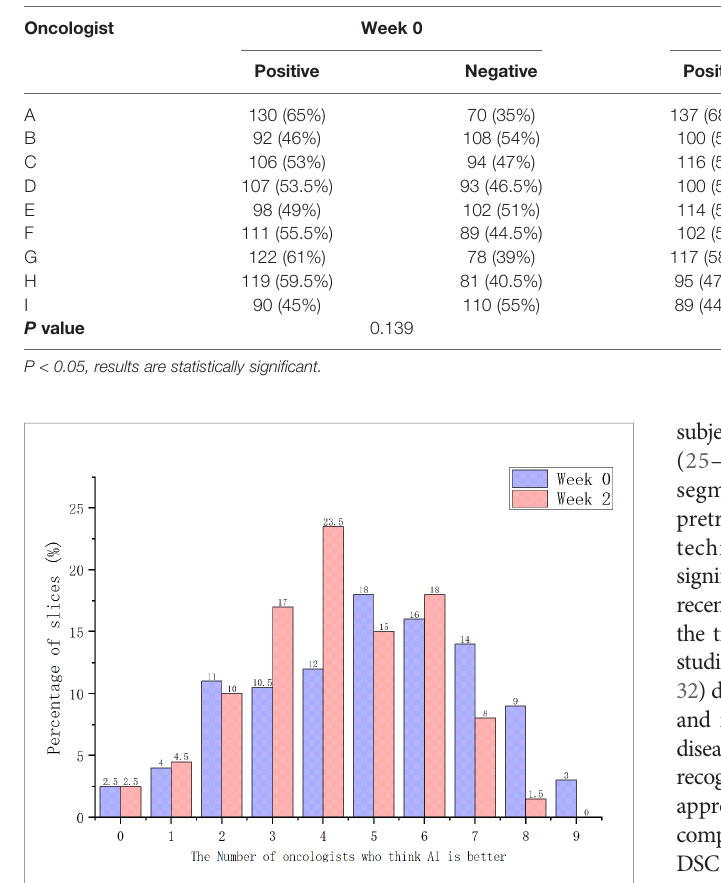
FIGURE 4 | The distribution map of the positive